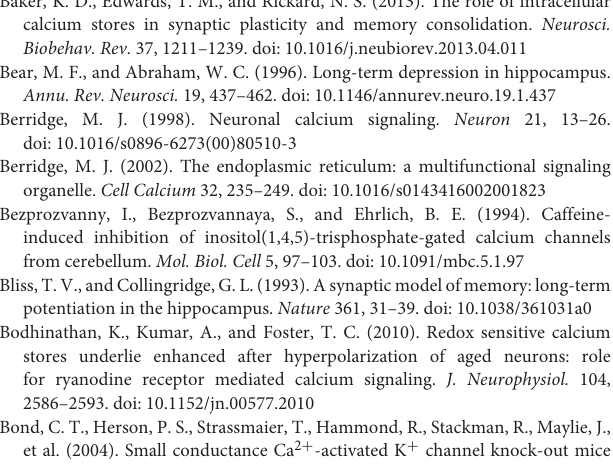
FIGURE S1 | The LTD induction protocol does not modify hippocampal CaMKII and Synapsin I protein contents. The protein contents of CaMKII-alpha (left panel), CaMKII-beta (center panel) and Synapsin I (right panel), measured 1 h after applying the LTD induction protocol to control (C) or to slices treated with inhibitory ryanodine (Rya), were not significantly different from the respective protein contents of naïve slices. Values represent Mean ± SE ( n = 3). Statistical analysis was performed with one-way ANOVA, followed by Tukey’s post hoc